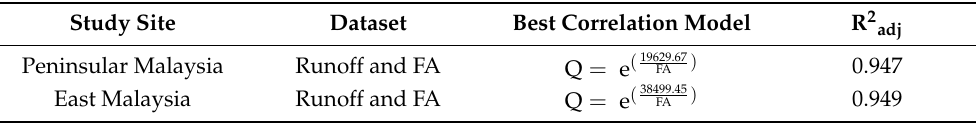
Table 9. The best correlation models for each dataset and the corresponding adjusted R-squared. Study